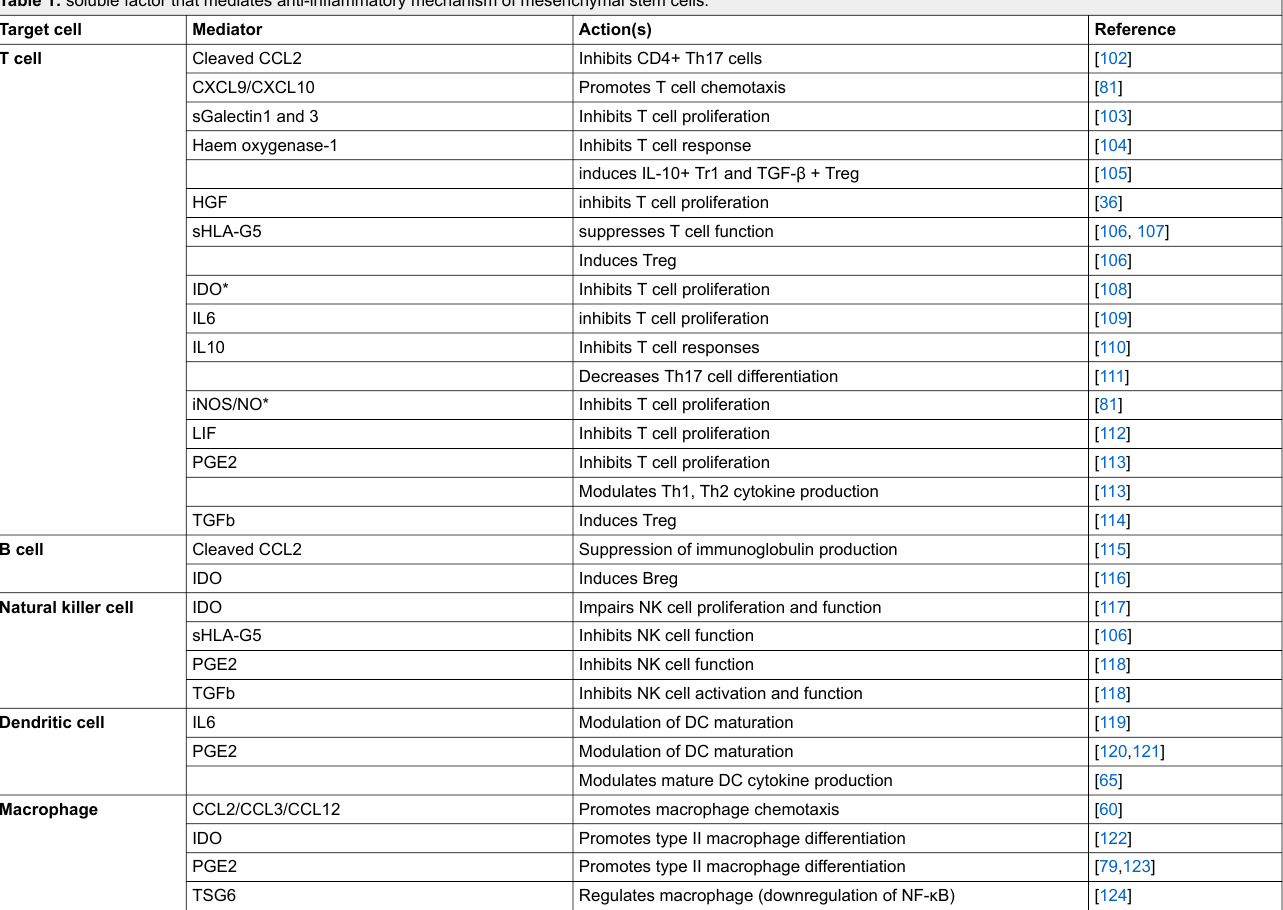
Table 1: soluble factor that mediates anti-inflammatory mechanism of mesenchymal stem